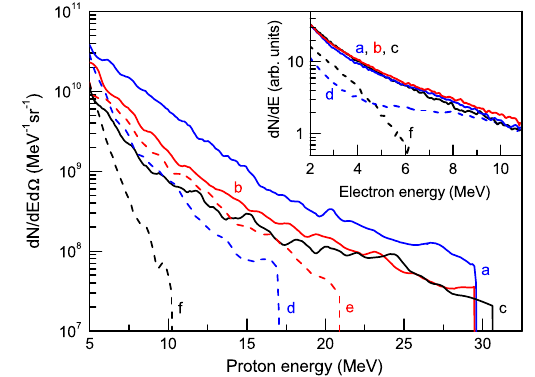
FIG. 3. Role of laser polarization and intensity. E max p as a fun- ction of laser intensity with s - (blue squares), p - (red triangles), and c -polarization (black circles) for ST (empty symbol) and DLT with 8 μ m – thick foam (full symbol). Horizontal error bars are reported only for the ST case to improve the clarity of the